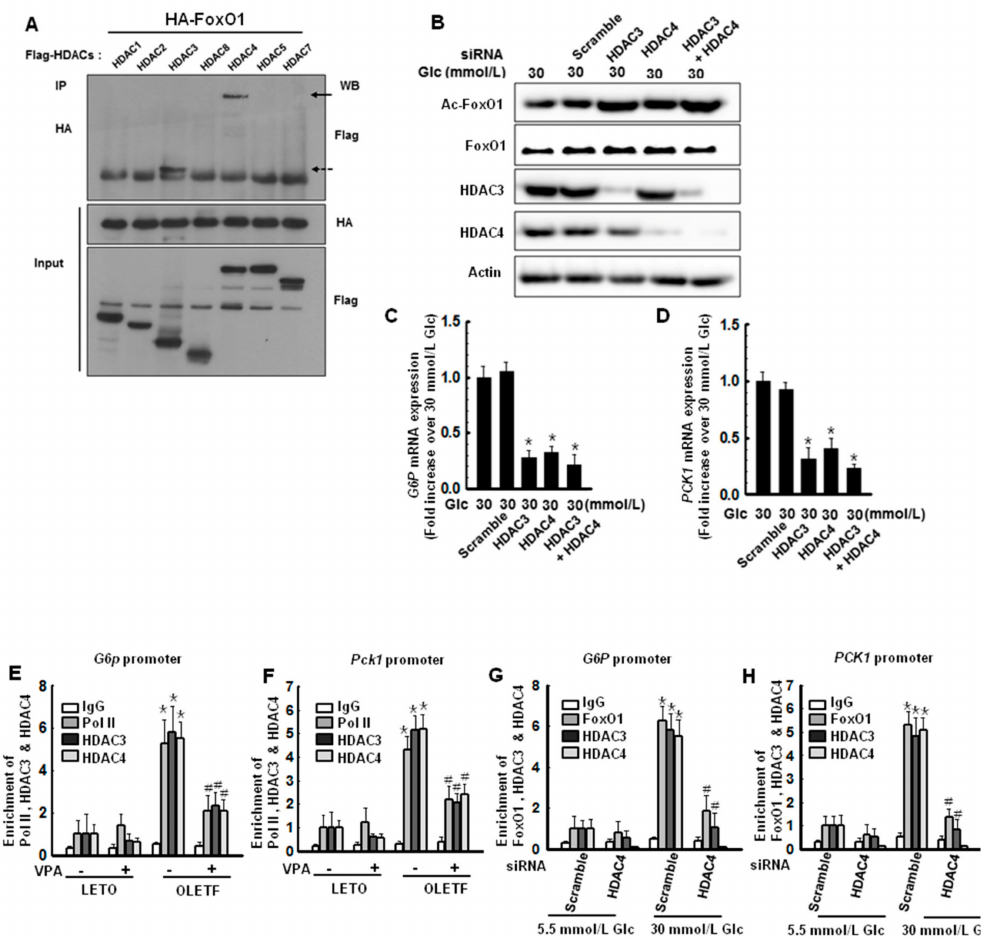
Figure 5. Histone deacetylase 3 (HDAC3) and HDAC4 are responsible for FoxO1 deacetylation. ( A ) HepG2 cells were co-transfected with hemagglutinin (HA)-FoxO1 and either Flag-HDAC1, Flag-HDAC2, Flag-HDAC3, Flag-HDAC4, Flag-HDAC5, or Flag-HDAC7. FoxO1 was precipitated by anti-HA antibodies and FoxO1-interacting HDACs were detected by western blotting with an anti-Flag antibody; ( B ) HepG2 cells were transfected with HDAC3 siRNA, HDAC4 siRNA, or a combination for 48 h, resulting in increased FoxO1 acetylation. Knockdown of HDAC3, HDAC4, or a combination significantly attenuated the expression of G6P ( C ) and PCK1 ( D ); The graphs show the mean ± SEM of three independent experiments (* p < 0.05 vs. scrambled). Recruitment of Pol II, HDAC3 or HDAC4 on G6p promoter ( E ) or Pck1 promoter ( F ) was decreased when VPA was administered for 20 weeks in OLETF rats. The graphs show the mean ± SEM of six independent experiments (* p < 0.05 vs. LETO vehicle; # p < 0.05 vs. OLETF vehicle); Recruitment of FoxO1, HDAC3 or HDAC4 on G6P promoter ( G ) or PCK1 promoter ( H ) was decreased when HDAC4 was depleted by HDAC4 siRNA in HepG2 cells. The graphs show the mean ± SEM of three independent experiments (* p < 0.05 vs. 5.5 mM Glc scramble; # p < 0.05 vs. 30 mmol/L scramble). IP: